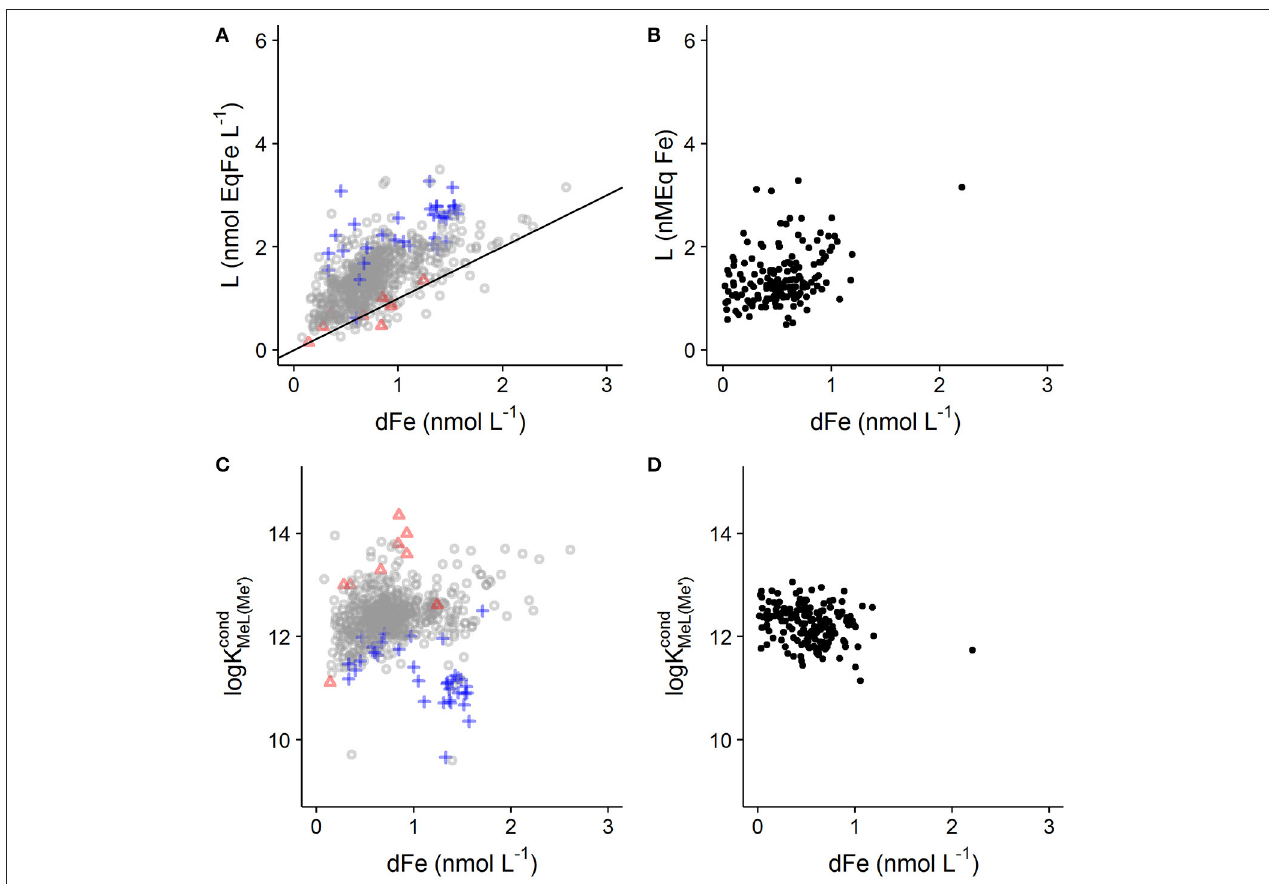
FIGURE 4 | Relationship observed between dissolved iron concentration, L i and log K cond MeL global compilation ( Caprara et al., 2016). Values of L i with 95% confidence intervals > 0.4nmol EqFe L − 1 are illustrated with blue crosses, whilst values of log K cond MeL (B,D) Show data from the Western Atlantic GEOTRACES cruise ( Gerringa et al., 2015). This data set was filtered to remove values of L i with 95% confidence intervals > 0.4 nmol EqFe L − 1 . A 1:1 line is added to (A) show where concentrations of excess ligand are very